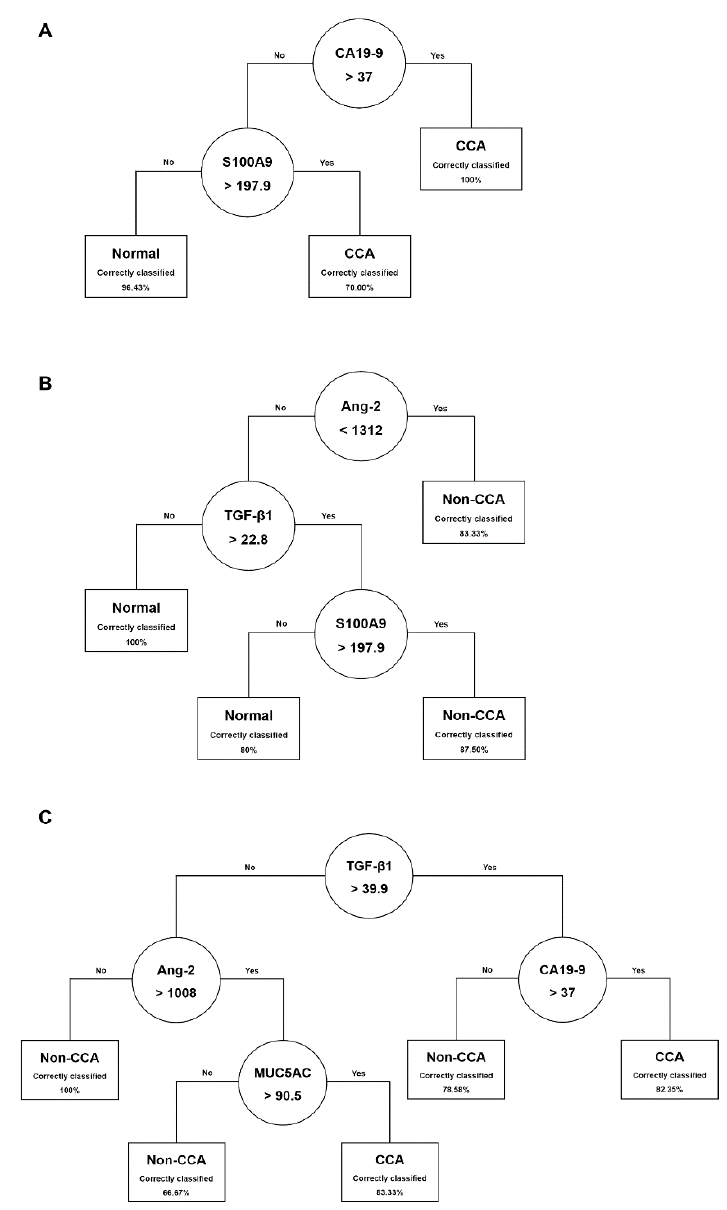
Figure 6. Decision tree (DT) models to classified CCA patients from healthy subjects ( A ), non-CCA patients from normal ( B ), and CCA patients versus non-CCA group ( C ) in the dataset used in this study. Establishing workflow potentially used in CCA diagnosis.